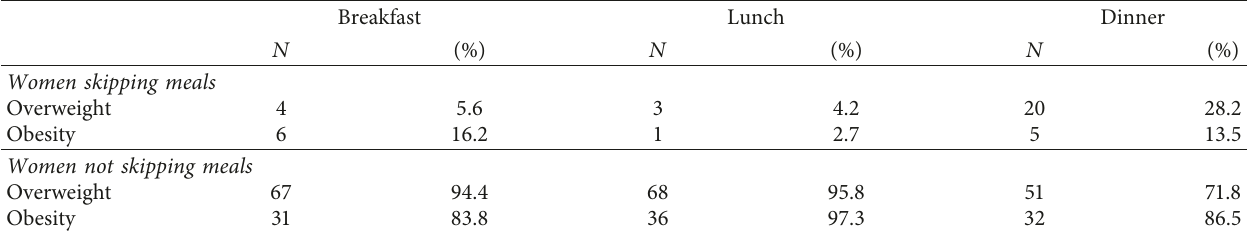
Table 5: Overweight and obesity among women who are (or are not) skipping meals. Breakfast Lunch Dinner N (%) N (%) N